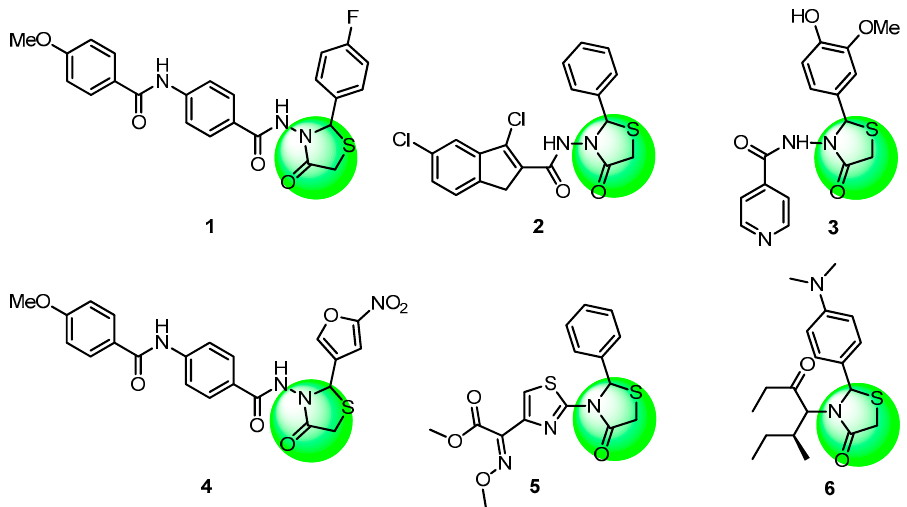
Figure 1. 4-Thiazolidinone scaffolds showing antimycobacterial activity.